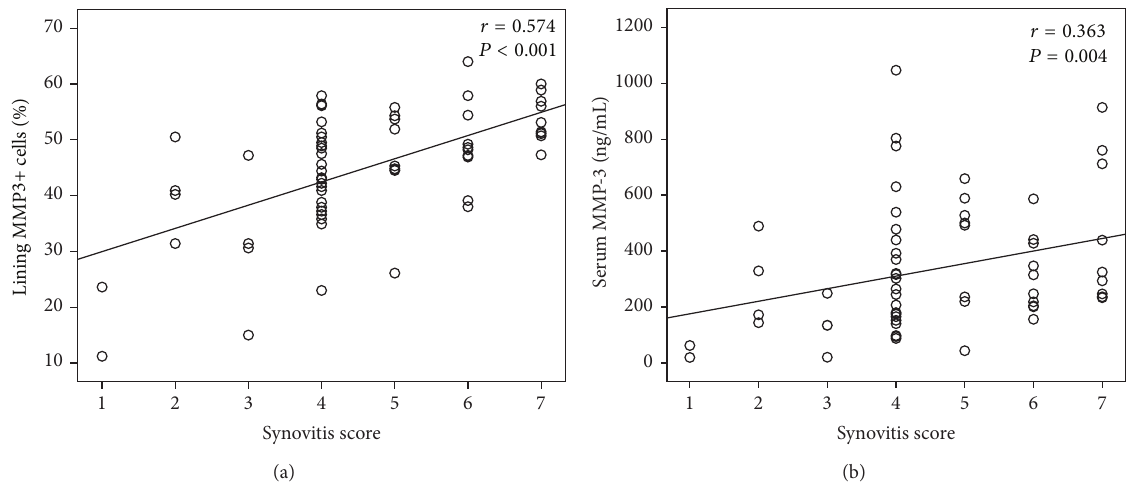
Figure 3: Correlation between synovial (a) and serum (b) MMP-3 with histological synovitis score. hyperplasia of lining layer, inflammatory infiltration,